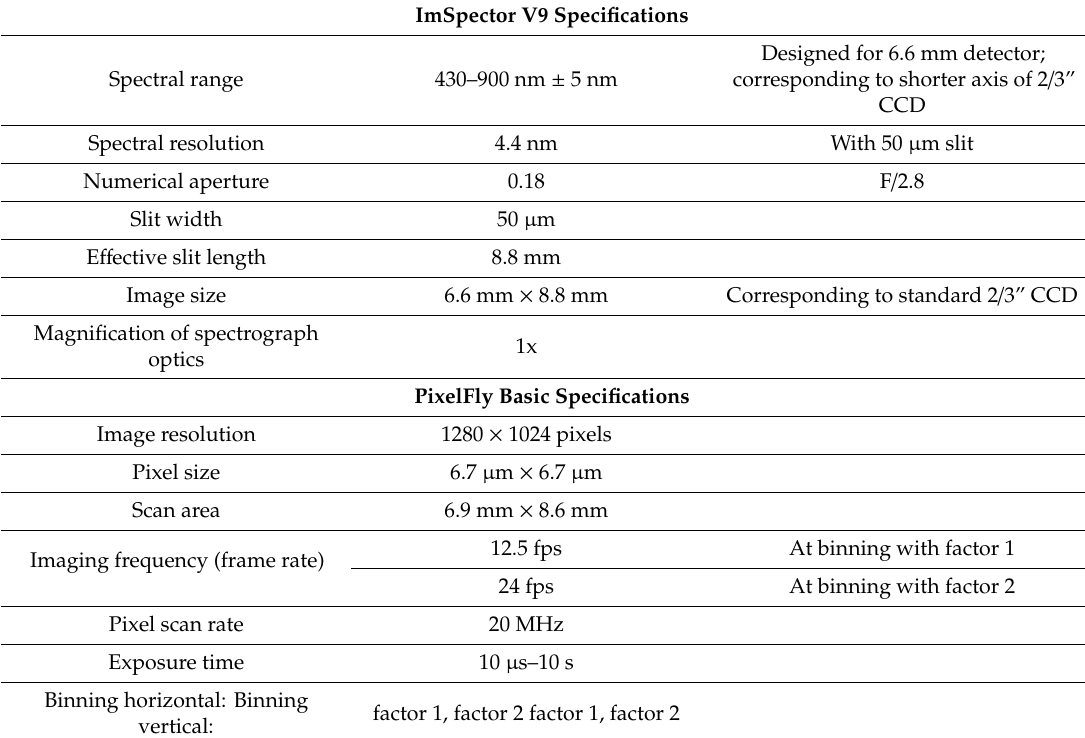
Table 1. Basic specifications of the ImSpector V9 line scanner [44] and PixelFly area CCD camera